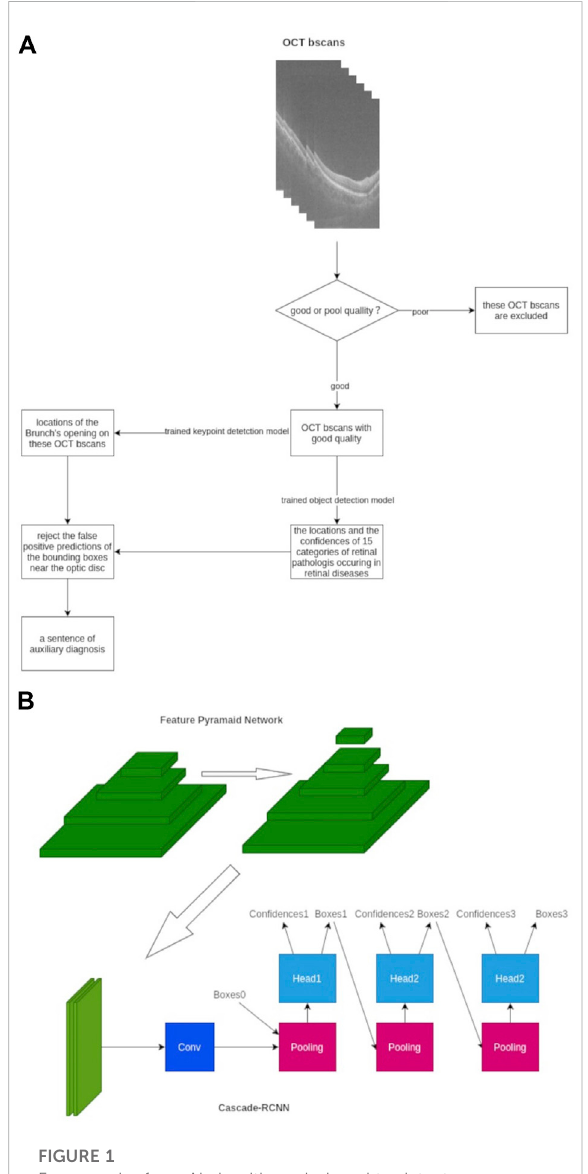
FIGURE 1 Framework of our AI algorithms designed to detect